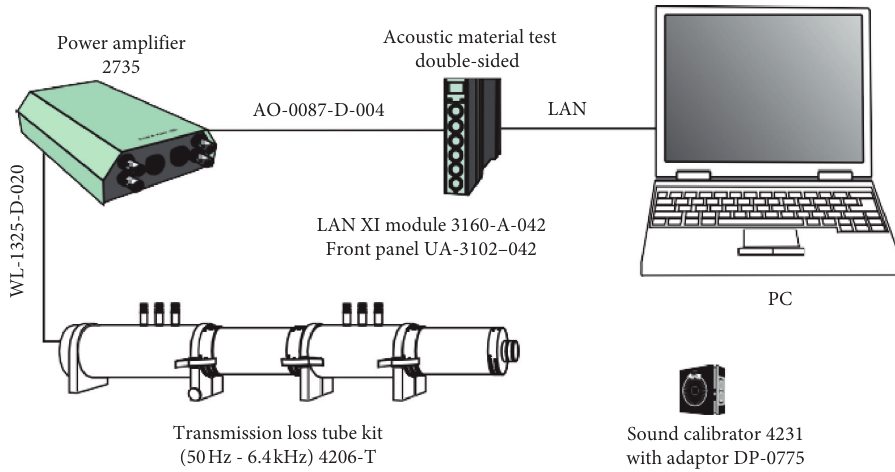
Figure 12: Experimental system for determining the transmission loss with the impedance tube.